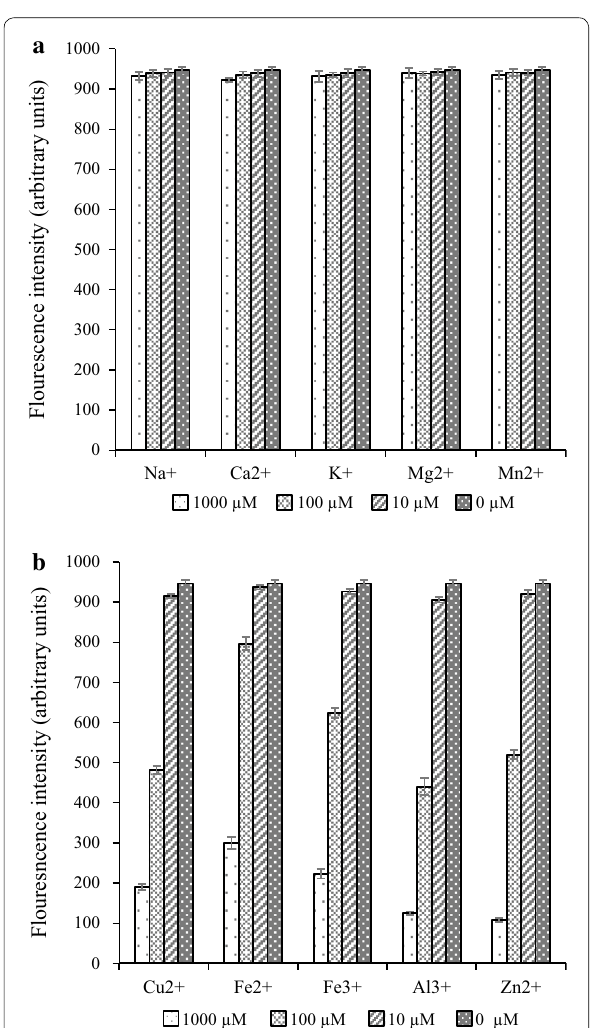
Fig. 4 The effect of different metal ions ( a Na + , Ca 2 + , K + , Mg 2 + , Mn 2 + ; b Cu 2 + , Fe 2 + , Fe 3 + , Al 3 + , Zn 2 + ) at different concentrations (1000, 100, 10 and 0 μM) on the DPA fluorescence